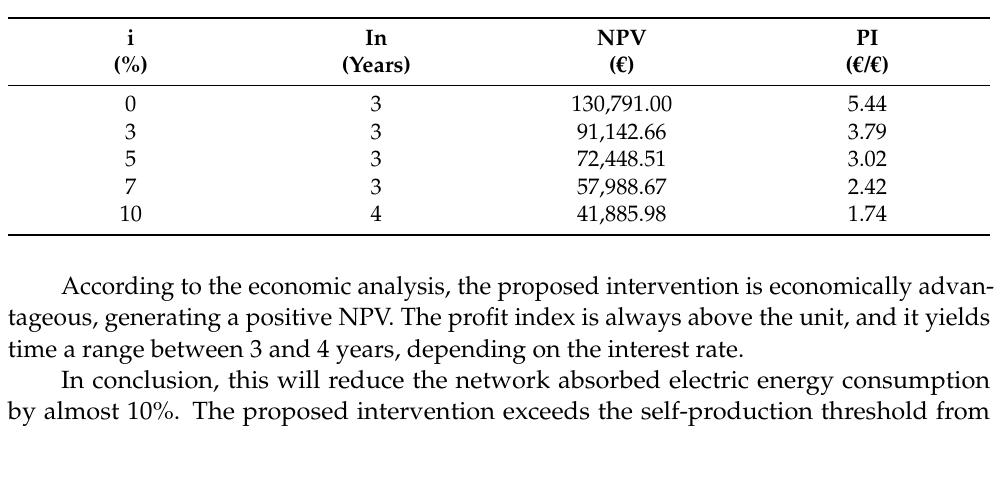
Figure 18. The net present value at fixed rate variation according to with 2020 Regione Lazio price list. ity Index PI) are shown in Table 10. Table 10. Economic indicators